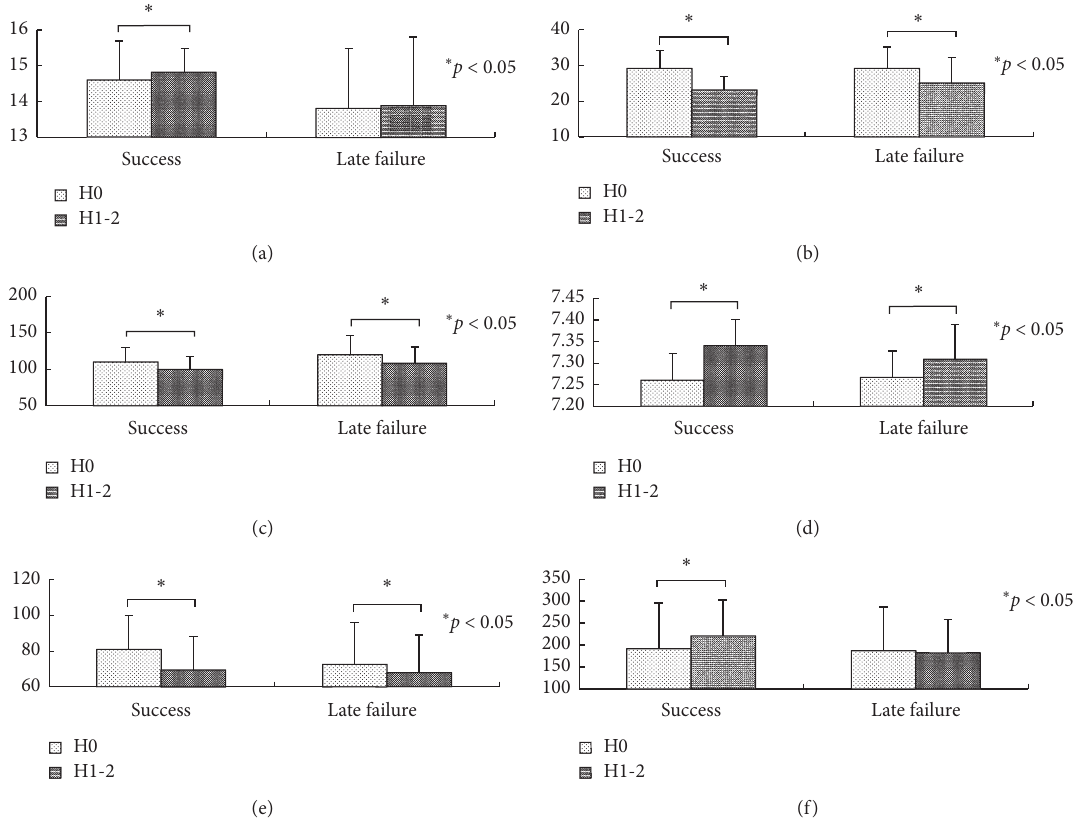
Figure 2: Comparisons between initiation and 1–2 h of NIV: (a) GCS, (b) respiratory rate (breaths/min), (c) heart rate (beats/min), (d) pH, (e) PaCO 2 (mmHg), and (f) PaO 2 /FiO 2